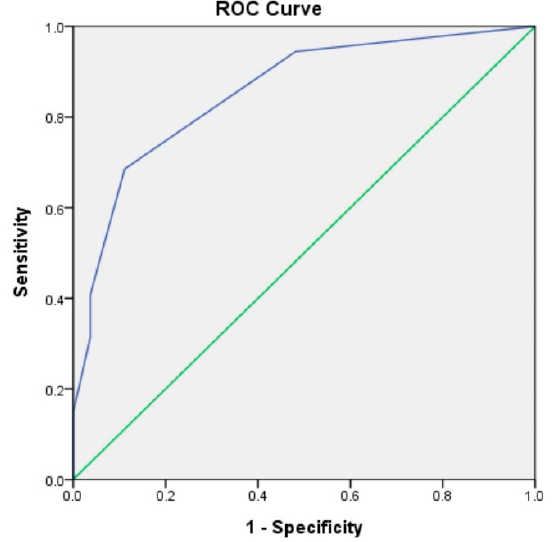
Figure 1. Receiver operating characteristic curve for clinical score in predicting the ischemic ovary torsion. The area under the curve was